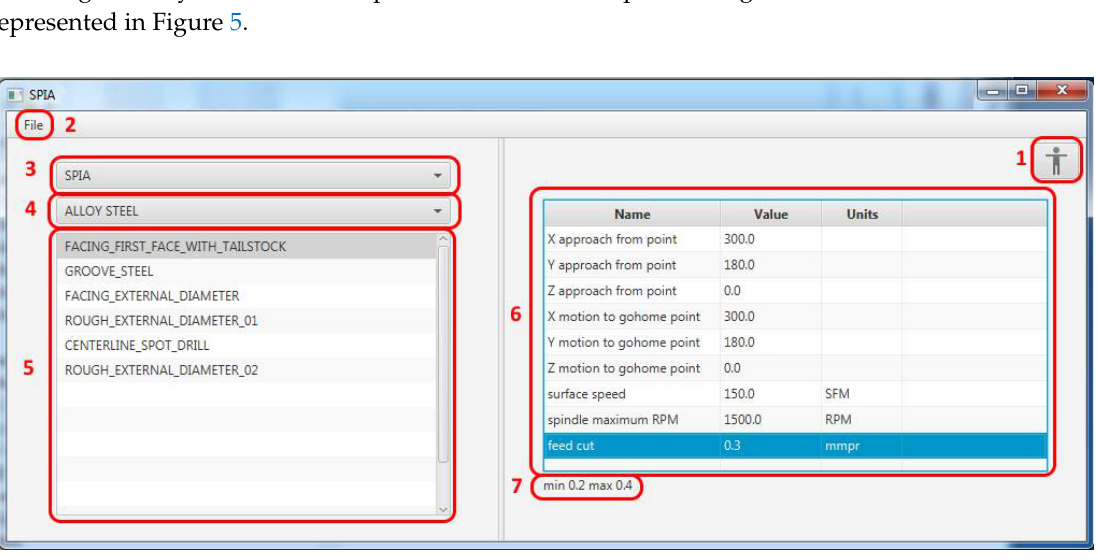
Figure 5. SPIA-KBM tool (user interface).